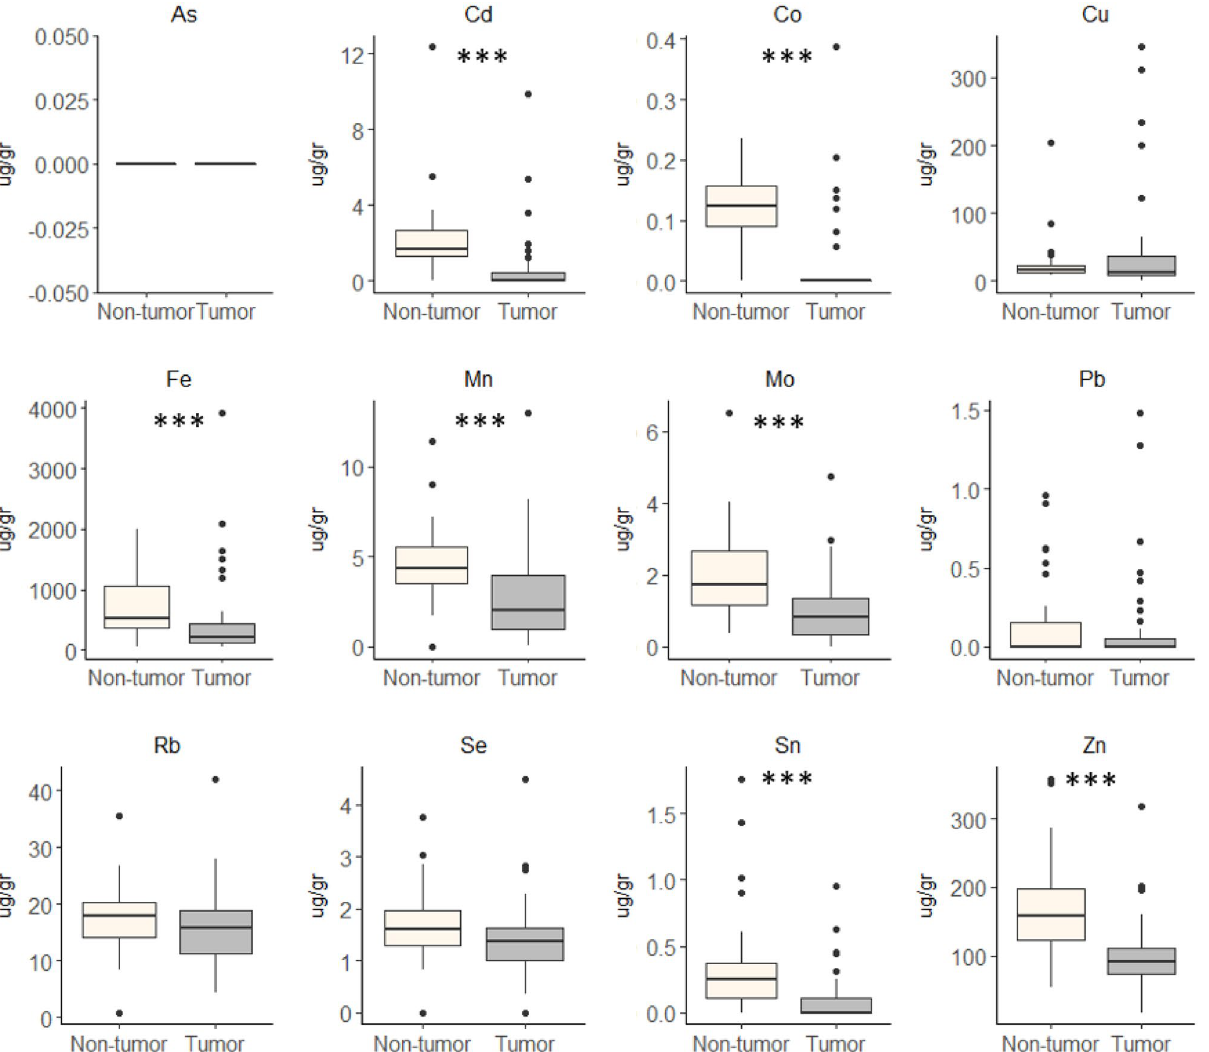
Figure 3. Comparison of metal concentration between tumoral and non-tumoral tissues in French cohort. Boxplot showing median, minimum, and maximum IQR values. Statistical test used was paired Mann–Whitney